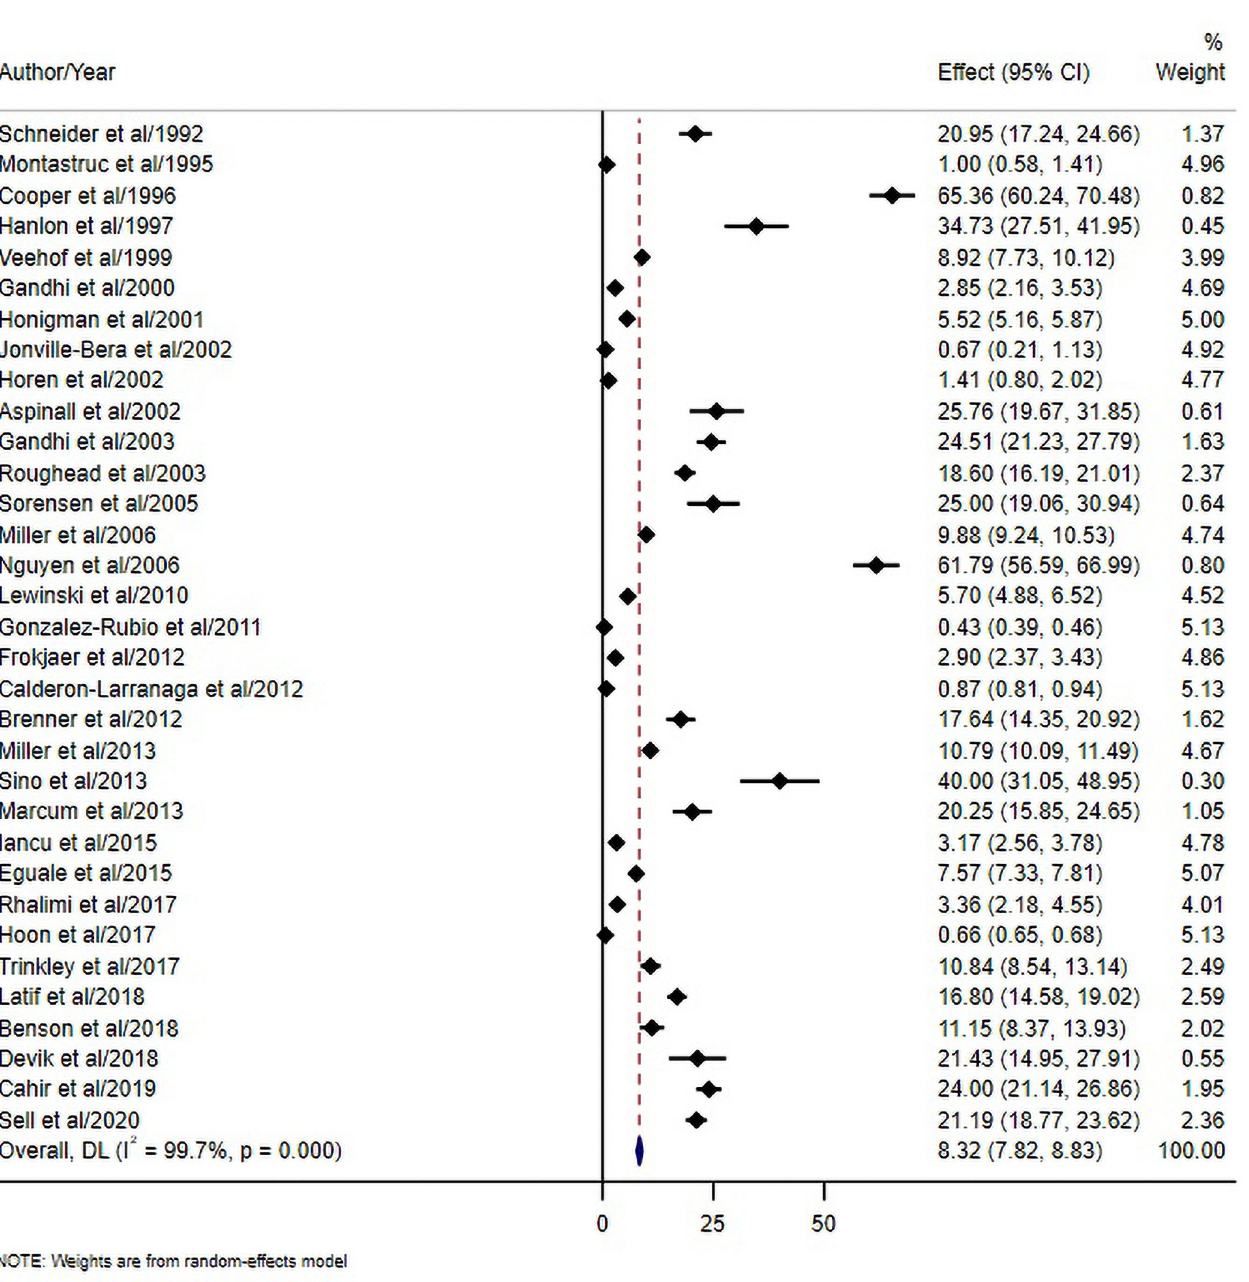
Fig 2. Prevalence of ADRs in the primary care